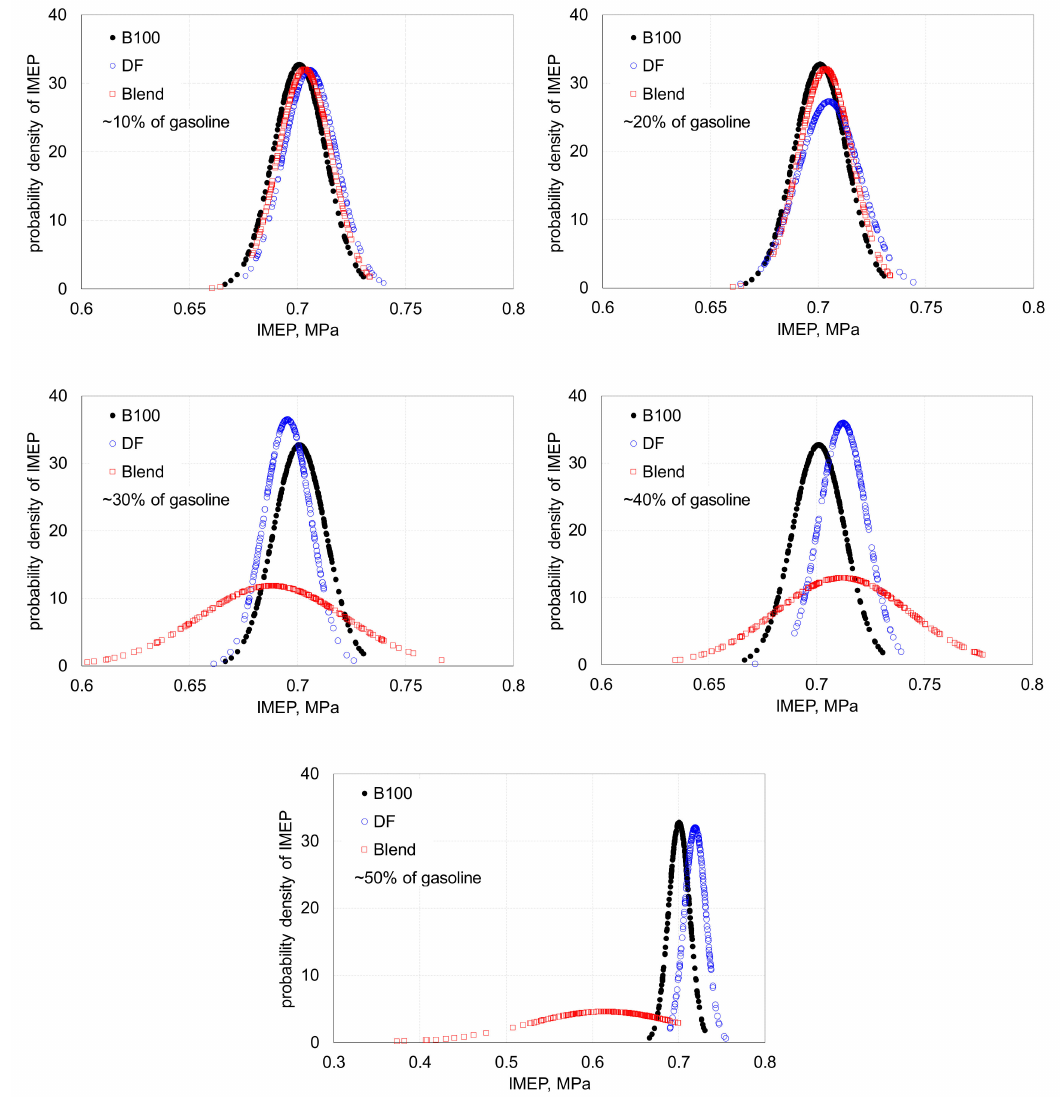
Figure 13. Probability density (PD) of IMEP for biodiesel-gasoline